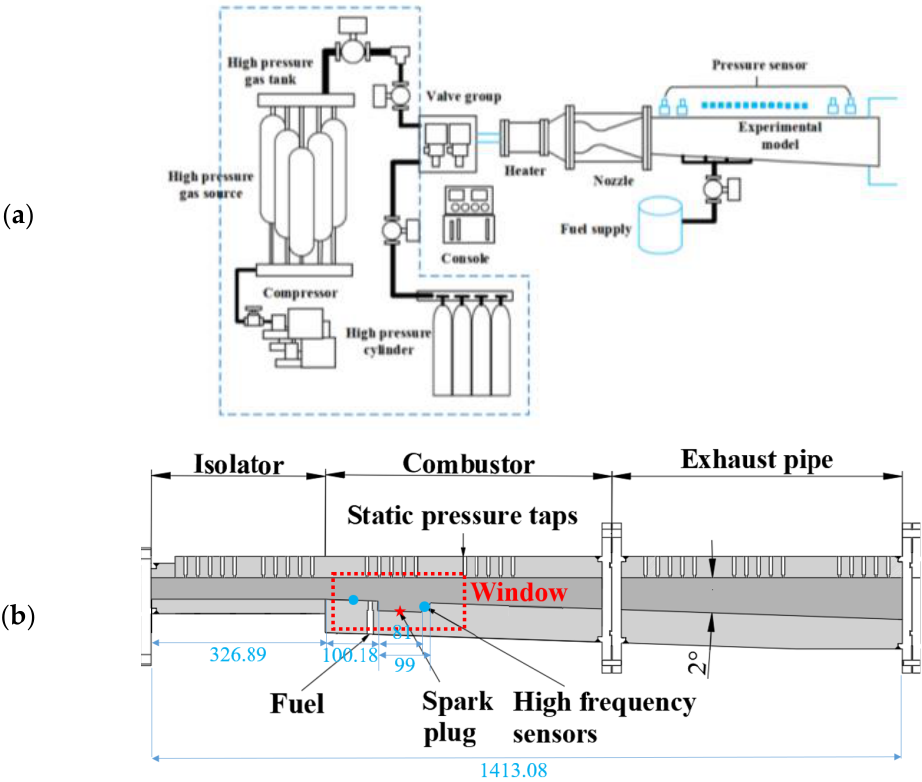
Figure 1. Scramjet experimental system: ( a ) system diagram; ( b ) scramjet combustor model and measurements points.